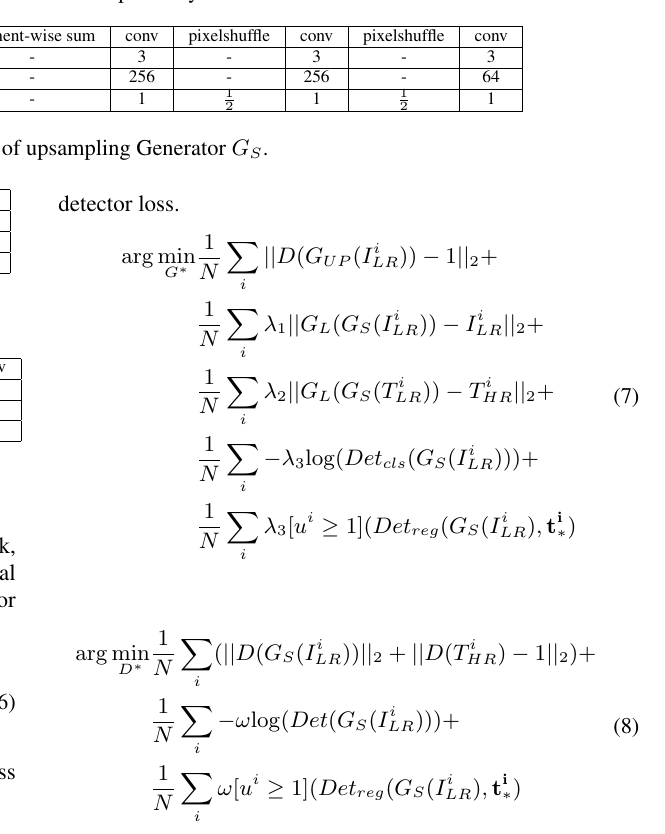
Figure 6. Examples of homography data augmentation. ( a ) Original image cropped from available dataset. ( b ) Schematic illustration of rotation along x or y axis. ( c )( d ) Results of rotation along y axis with − 15 ◦ and 15 ◦ respectively. ( e )( f ) Results of rotation along x axis with − 15 ◦ and 15 ◦ respectively.